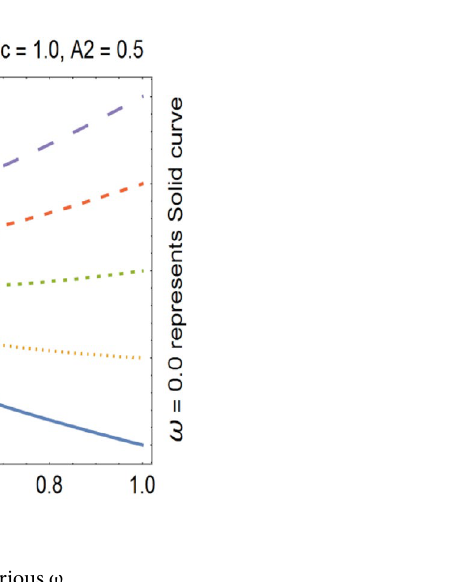
Figure 14. Tangential velocity profile for various